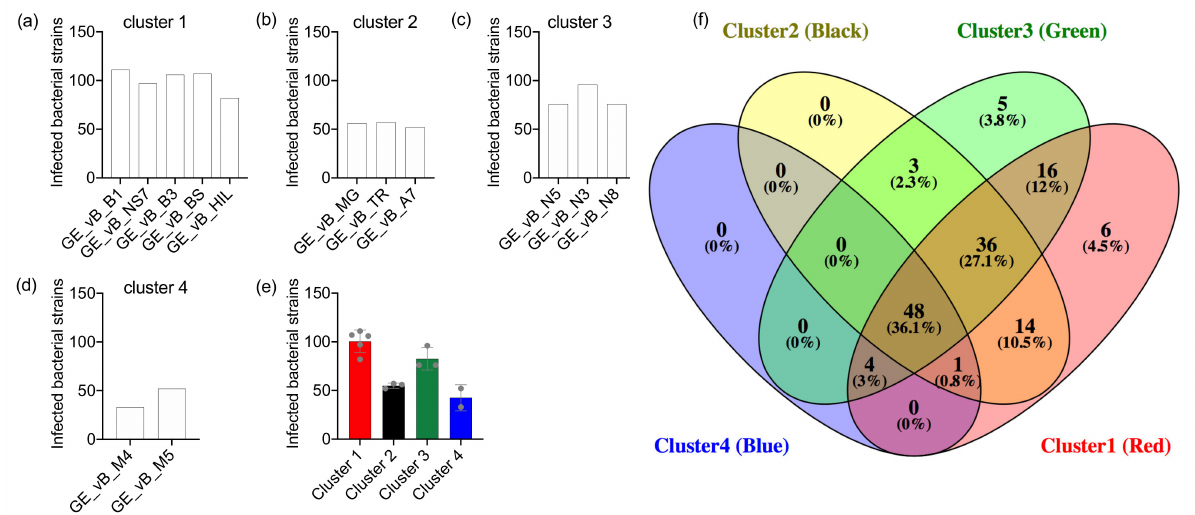
Figure 3. Target-range of Salmonella phages in different phage infection profile clusters. The number of infected Salmonella bacteria strains per each phage are presented for ( a ) cluster 1, ( b ) cluster 2, ( c ) cluster 3, and ( d ) cluster 4. ( e ) The number of infected Salmonella bacteria strains per phage cluster: Median values and 95%CIs are presented. ( f ) Venn diagram of phage-target overlap amongst phage